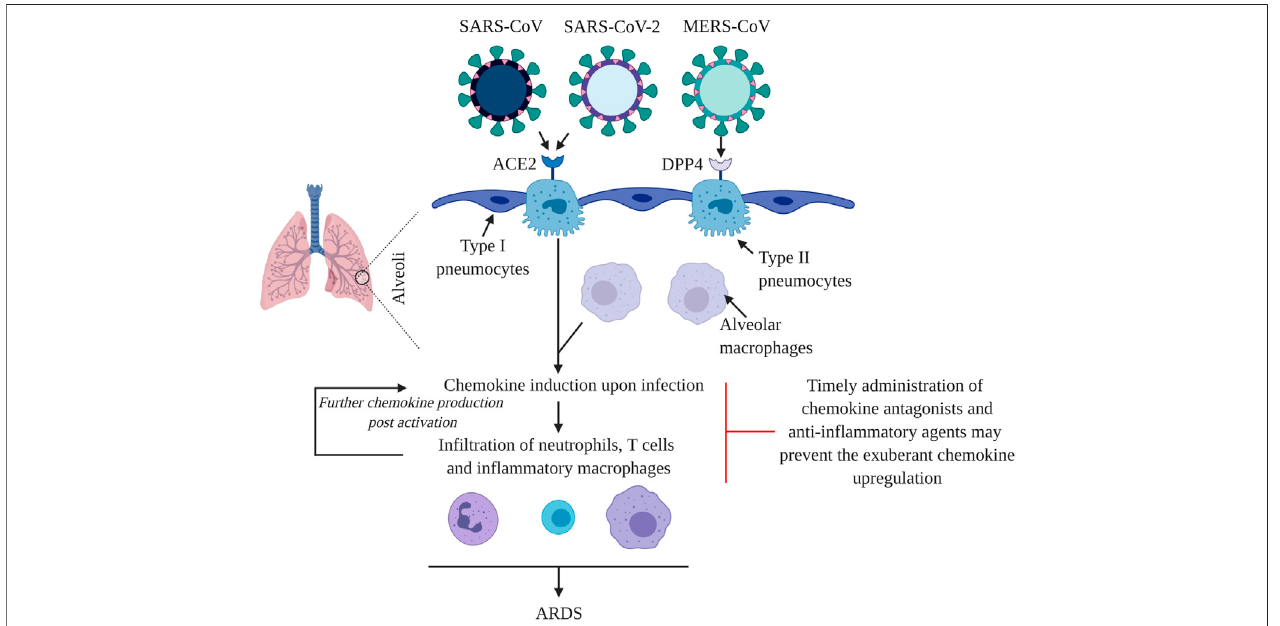
Figure 1 | Virulent CoVs cause ARDS by inducing a chemokine/cytokine storm in lungs. SARS-CoV, SARS-CoV-2 and MERS-CoV primarily infect type II pneumocytes in the alveoli. The fi rst two viruses use ACE2 as their receptor, while MERS-CoV uses DPP4 to gain entry into cells. The viruses propagate and subsequently infect other cell types including alveolar macrophages to induce chemokines, which mediatethe in fi ltration of in fl ammatory macrophages, neutrophils and T cells. Upon activation, these cells further the production of chemokines, that contribute towards pulmonary damage and the development of ARDS. Systemic chemokine/cytokine storm may result in multiple organ dysfunction syndrome and fatality. Application of chemokine receptor antagonists and anti-in fl ammatory molecules such as corticosteroids and BTK inhibitors may dampen the leukocyte in fi ltration in lungs, reducing the ensuing morbidity and mortality.